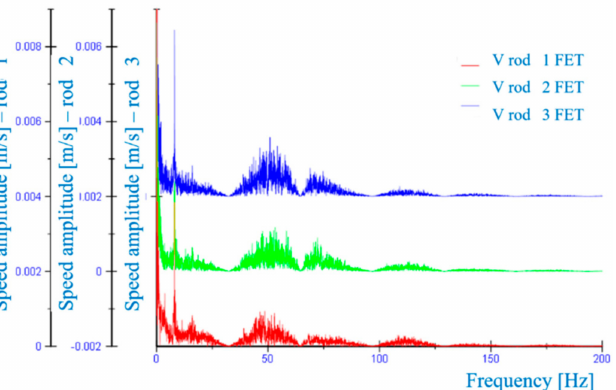
Figure 14. Frequency distribution for the 1st test borehole on test stand No.